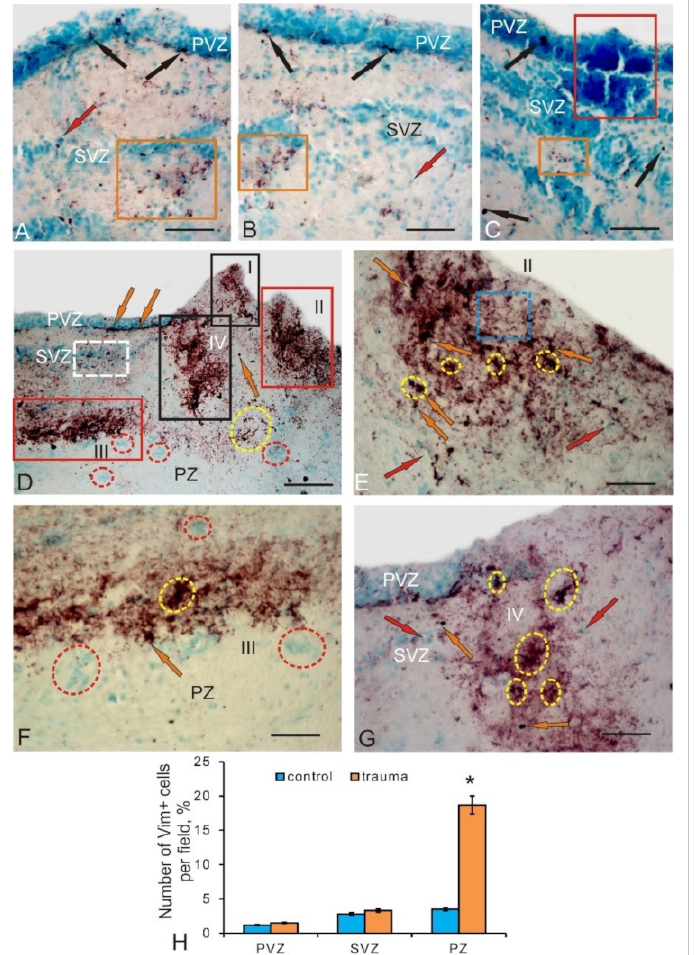
Figure 6. Localization of vimentin in the mesencephalic tegmentum of juvenile chum salmon, Oncorhynchus keta on day 3 post-injury. ( A ) In the medial tegmentum: Vim + NPCs in the basal part of the PVZ (black arrows) and Vim– cells (red arrows); the orange rectangle outlines an accumulation of Vim + granules in the SVZ. ( B ) In the lateral tegmentum (designation as in Figure 6A). ( C ) In the PVZ adjacent to the area of injury: patterns of increased density of distribution of Vim– cells (outlined by red rectangle), forming hypertrophic accumulation of cells; ( D ) general view of the injured zone and foci (I–IV) of additional vimentin expression: an Vim + NPCs cluster outlined by a yellow dotted line, reactive neurogenic niches (in red dotted ovals), Vim + NPCs in the basal part of the PVZ (orange arrows), and a Vim + NPCs cluster in the SVZ (outlined by a white dotted line). Representative images of foci of additional expression of vimentin. ( E ) In PVZ (II): an extracellular deposition of vimentin is outlined by blue dotted line (other designations as in Figure 6D). ( F ) In PZ (III). ( G ) In SVZ (IV) at a higher magnification. IHC vimentin labeling in combination with methyl green staining. ( H ) The quantitative ratio of Vim + cells in the control and after traumatic injury. ( n = 5 in each group; * p ≤ 0.05, significant di ff erence vs. control groups); Student–Newman–Keuls test. Scale bar: (A–C,E–G) = 100 µ m; (D) = 200 µ